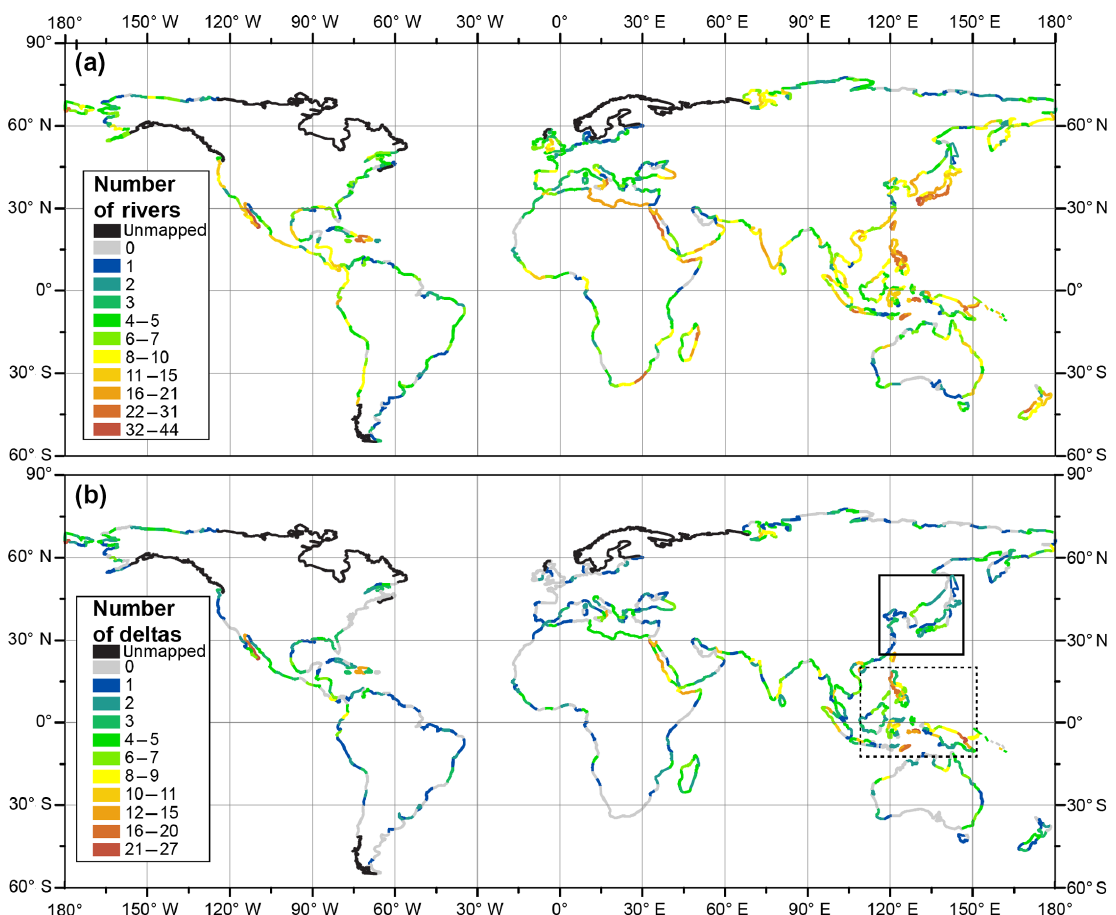
Figure 2. Global distribution of coastal (a) rivers (includes both river mouths and deltas) and (b) deltas only. Each colored line segment is 3 ◦ long. Black (solid and dashed) boxes refer to hotspots of delta formation discussed in the text.